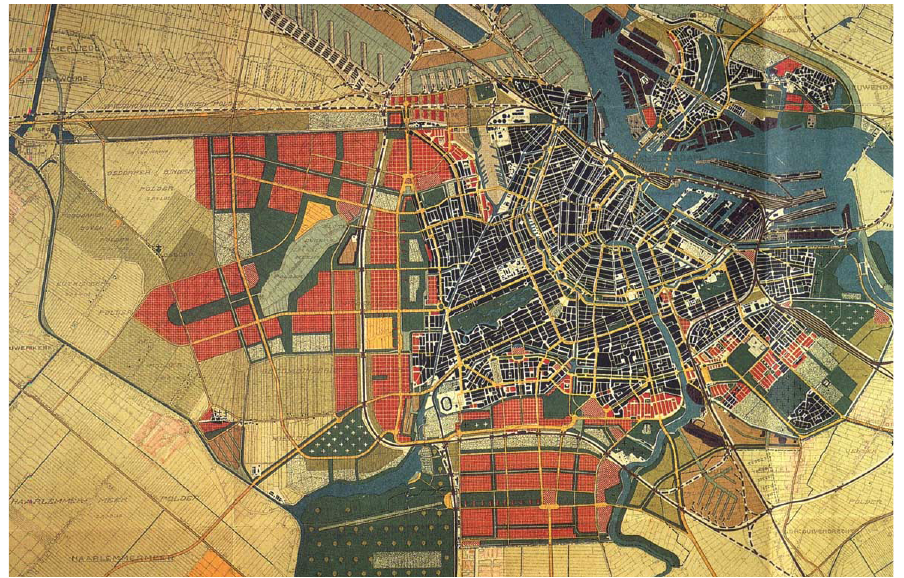
Figure 3. The Amsterdam AUP by Van Eesteren de Graaf and Van Loohuizen, 1939, which shows the field for new construc- tion (red) divided by connected urban green zones (green). Source: Wikipedia